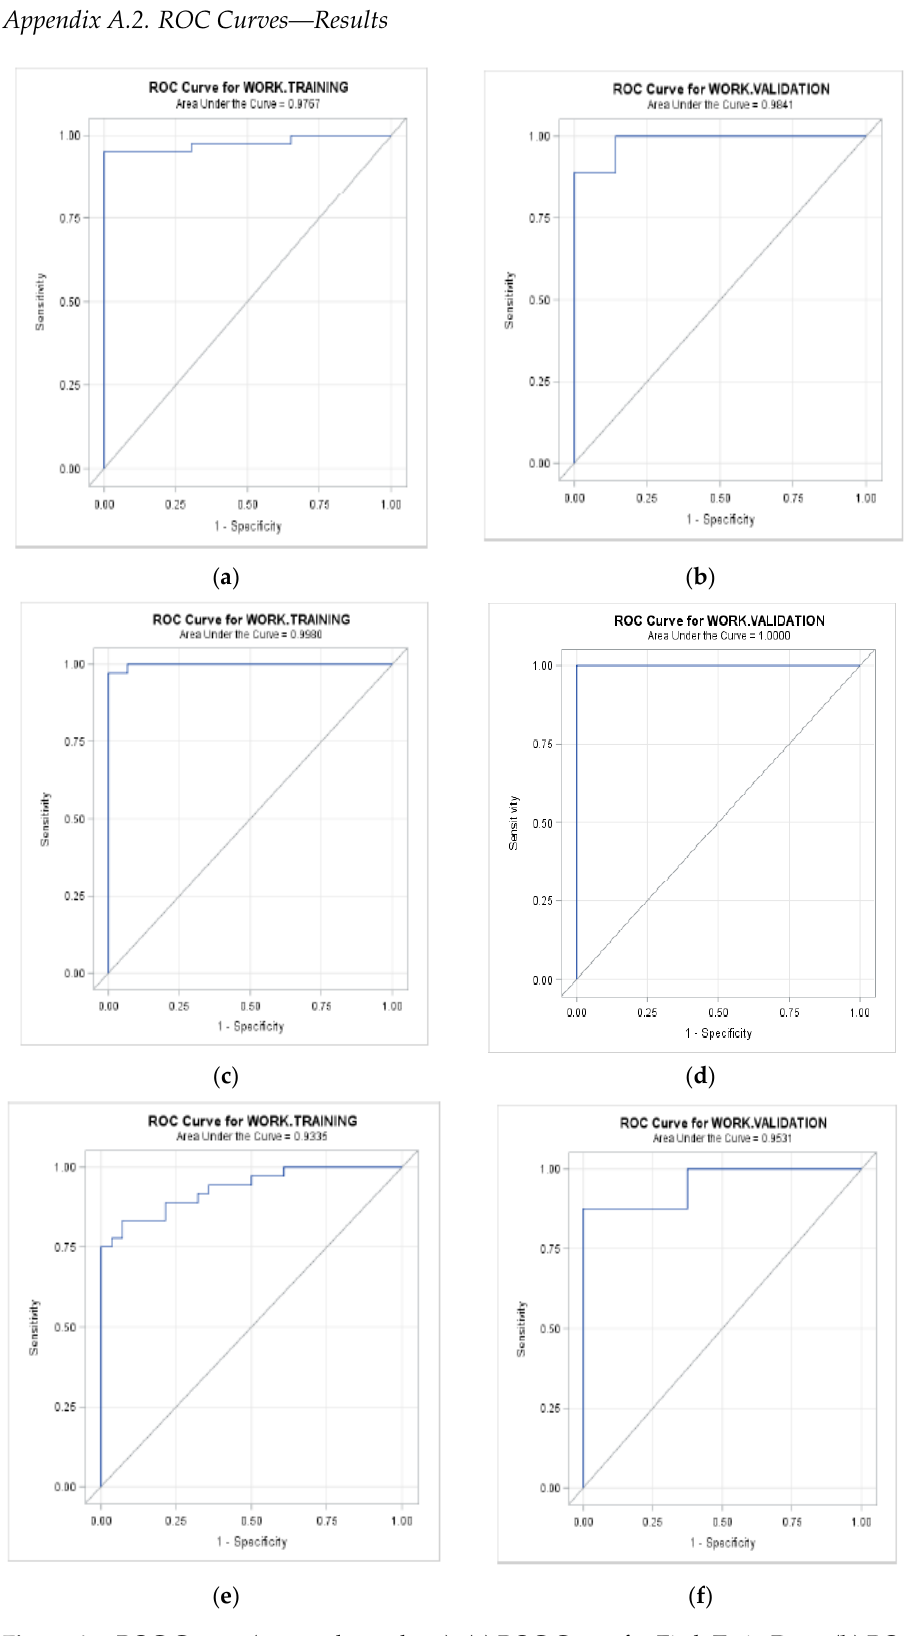
Figure A2. ROC Curves (source: by authors). ( a ) ROC Curve for Fitch Train Data. ( b ) ROC Curve for Fitch Test Data. ( c ) ROC Curve for Moody’s Train Data. ( d ) ROC Curve for Moody’s Test Data. ( e ) ROC Curve for SNPoor Train Data. ( f ) ROC Curve for SNPoor Test